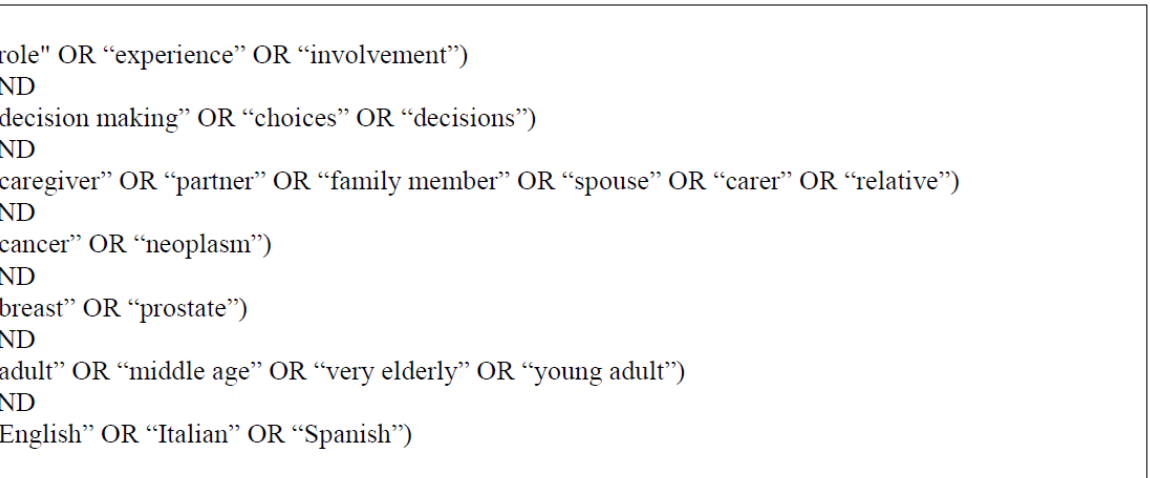
Figure 1. Database search terms.